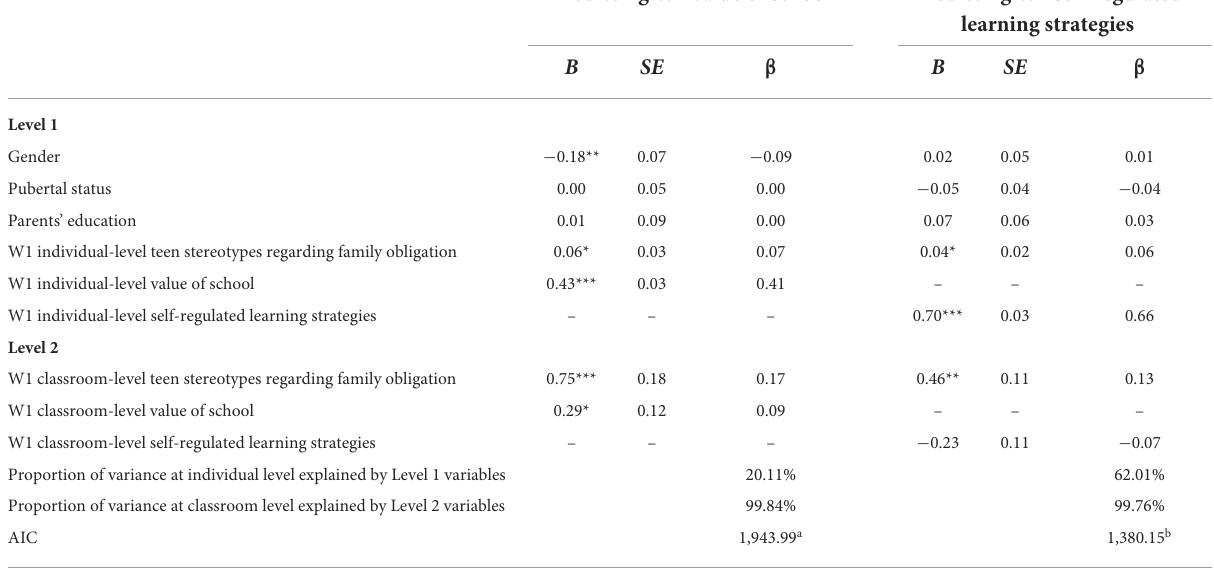
TABLE 2 Multilevel modeling predicting academic adjustment from teen stereotypes regarding family